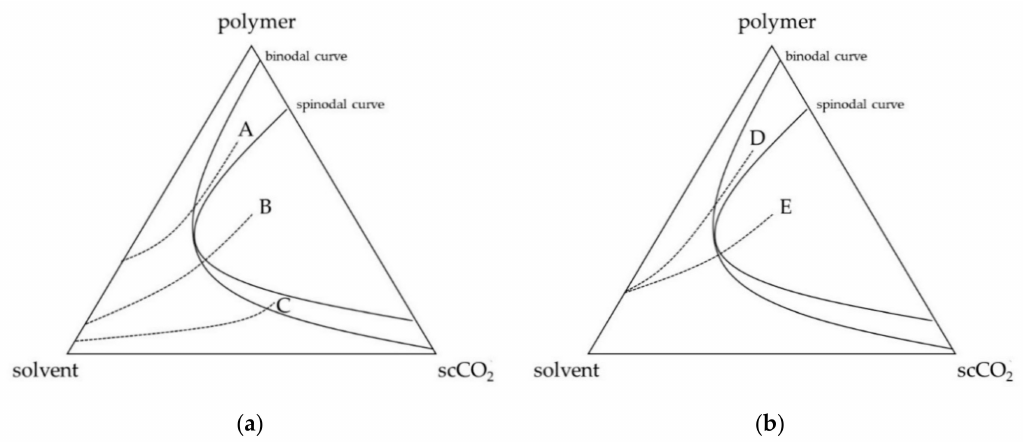
Figure 5. Qualitative ternary diagrams; ( a ) paths at di ff erent starting polymer concentrations at 8 MPa and 45 ◦ C; ( b ) paths at di ff erent operating pressures at 160 mg / mL and 45 ◦